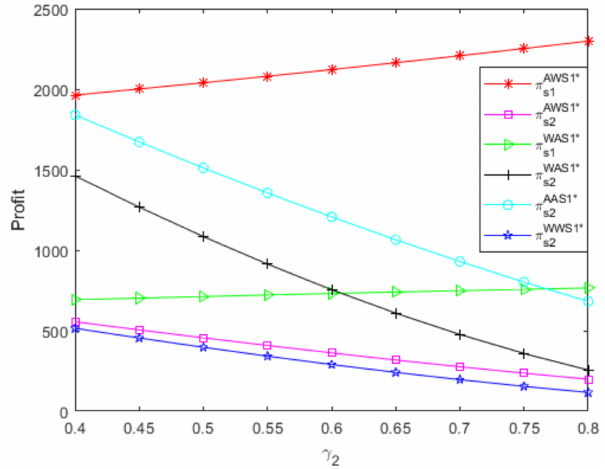
Figure 5. Changes of two suppliers’ profits with γ 2 .